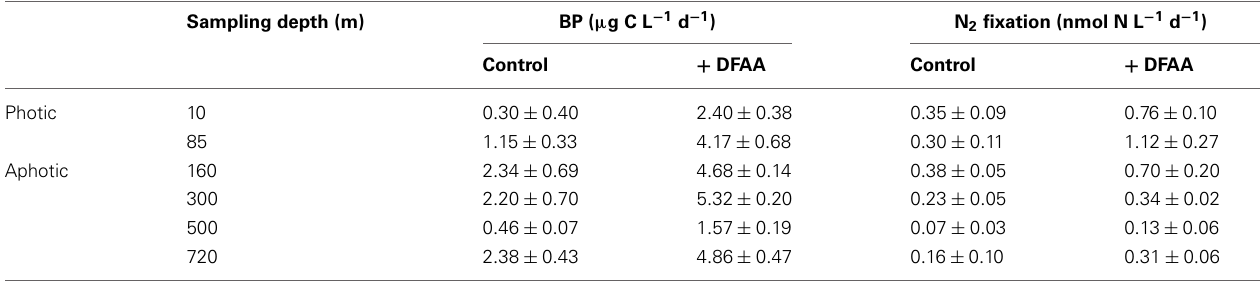
Measurements are based on 3-4 replicates for each sampled